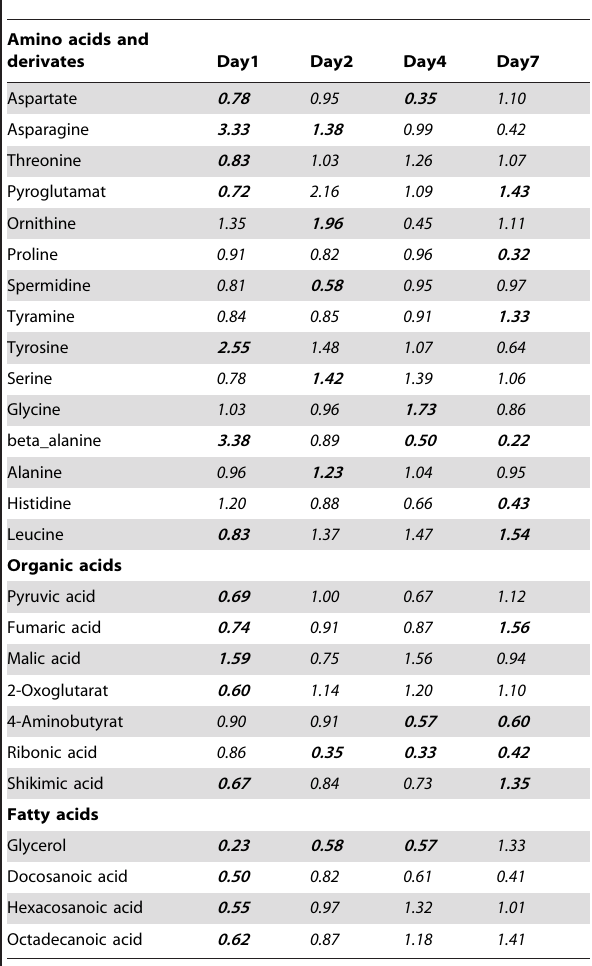
Table 1. PARP activity and effects on primary metabolism.